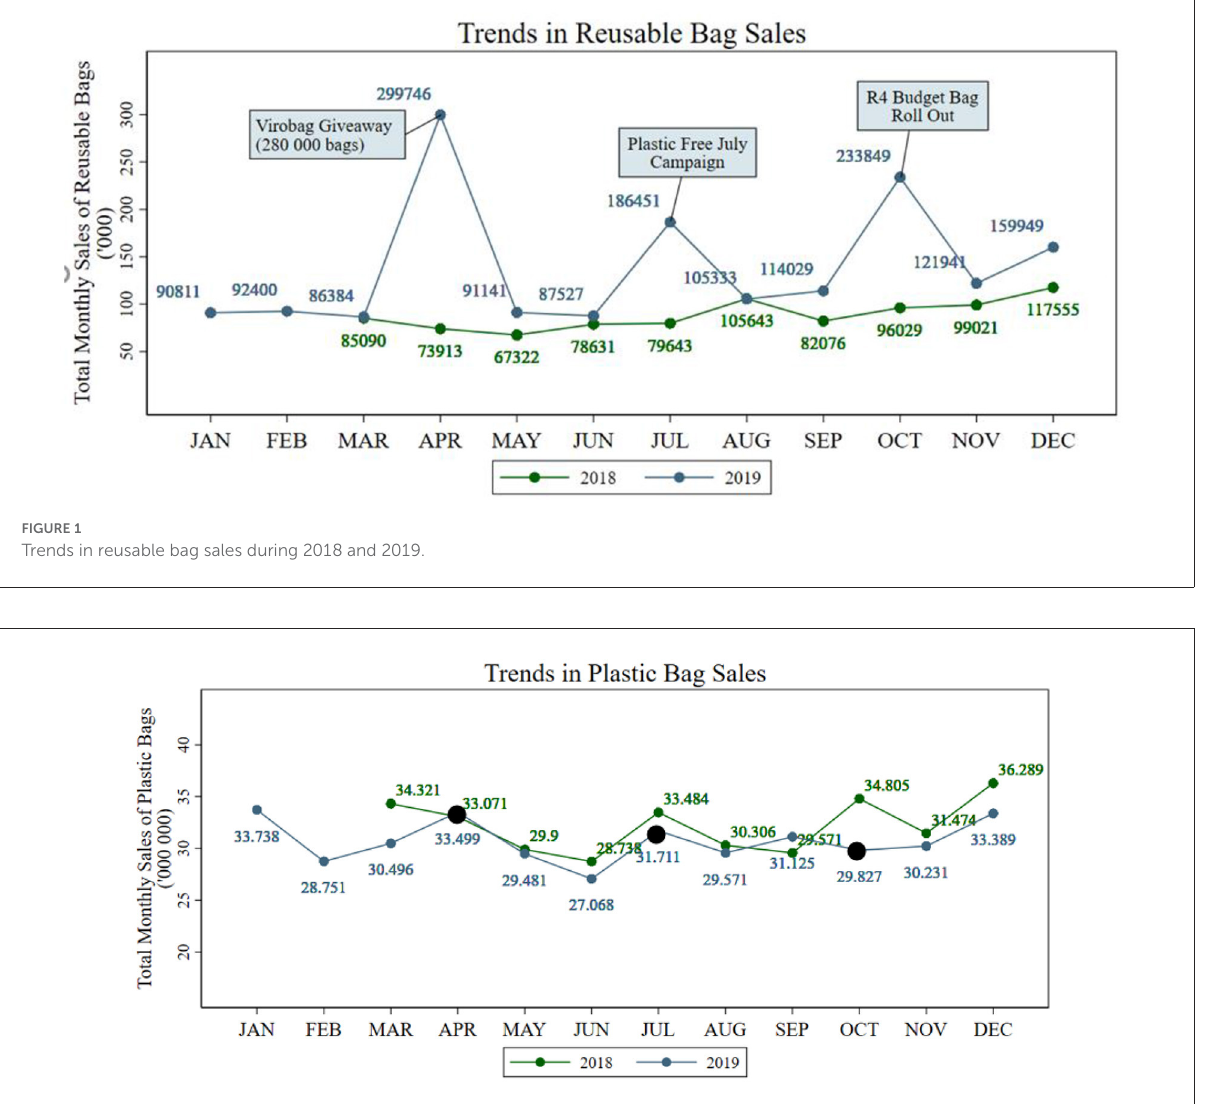
FIGURE2 Trends in plastic bag sales during 2018 and